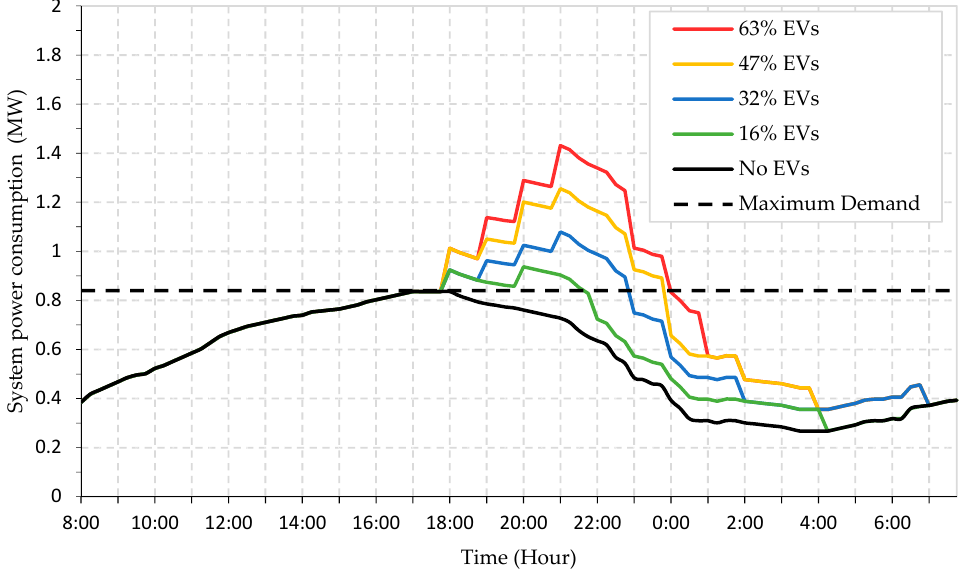
Figure 6. Impact of random uncoordinated EVs’ charging within 18:00–07:00 h on system load.